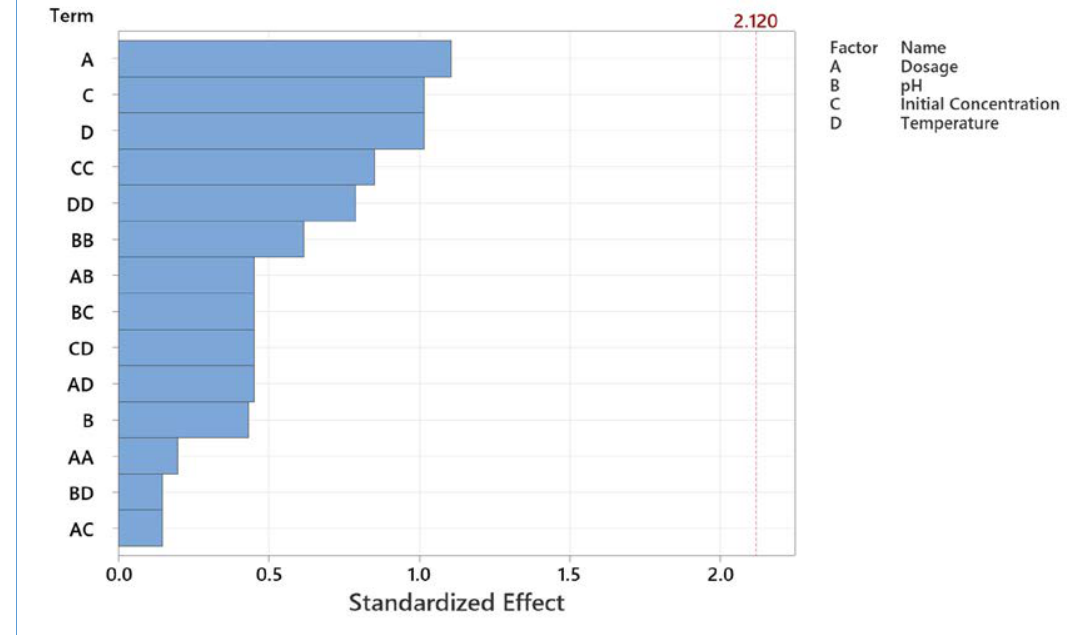
Fig. 2: Pareto chart analysis for removal efficiency